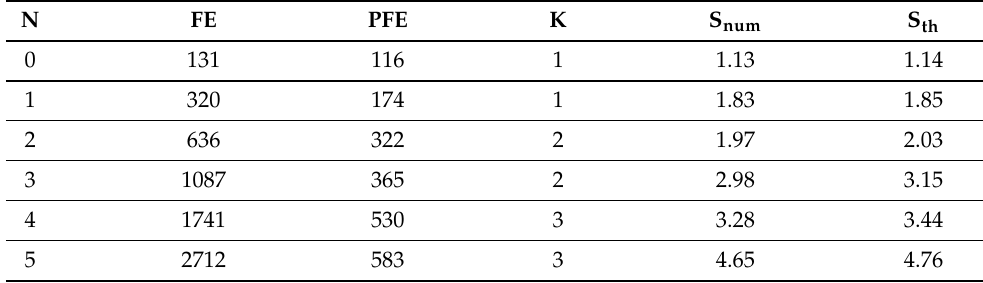
Table 11. Smooth periodic wave test case runtime (in sec) using FE and PFE schemes and speedup of